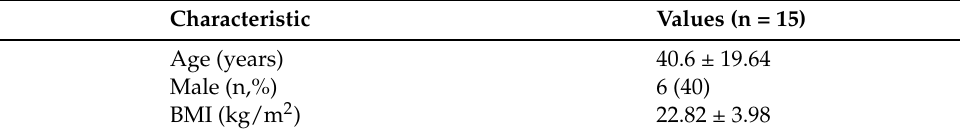
Table 1. Demographics of the 15 subjects in the QDB.